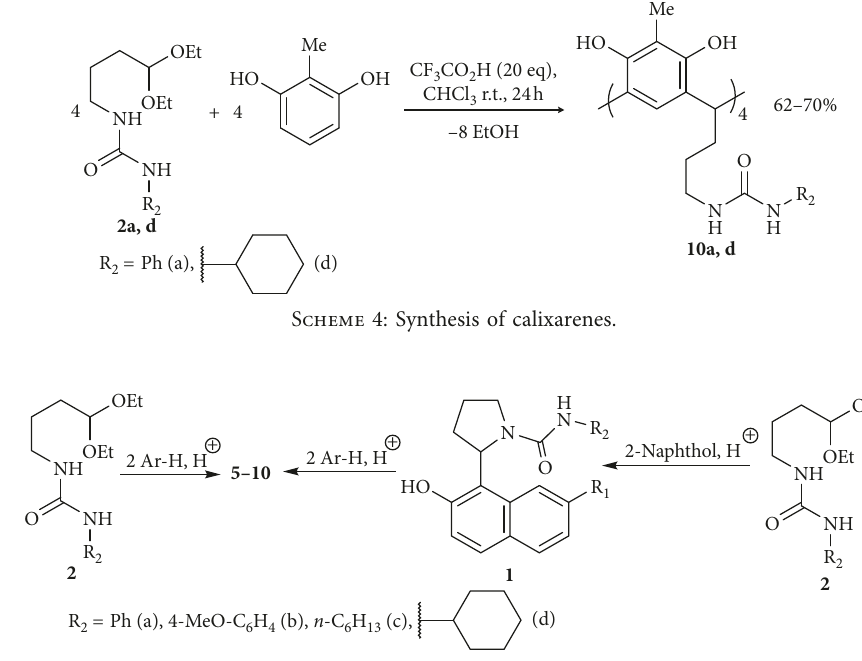
Scheme 5: Synthesis of 2-arylpyrrolidines and polyphenols.